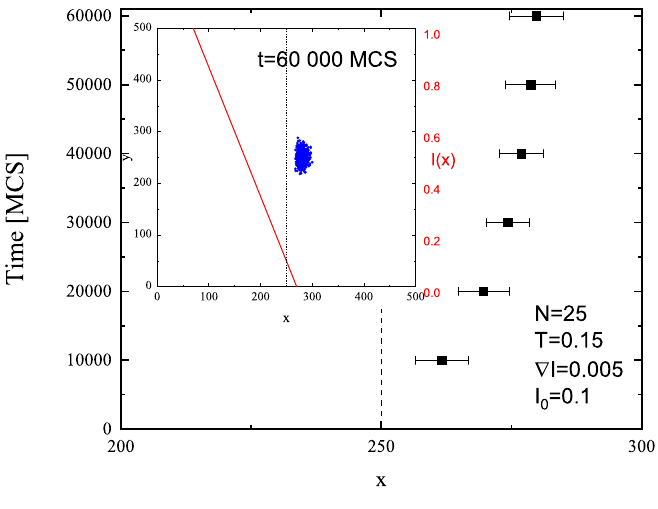
Figure 13. Averaged position of CM in x direction in function of MC time for PI model and final positions of CM of chains after t = 6 × 10 4 MCS (inset). ∇ I = 0.005, I 0 =